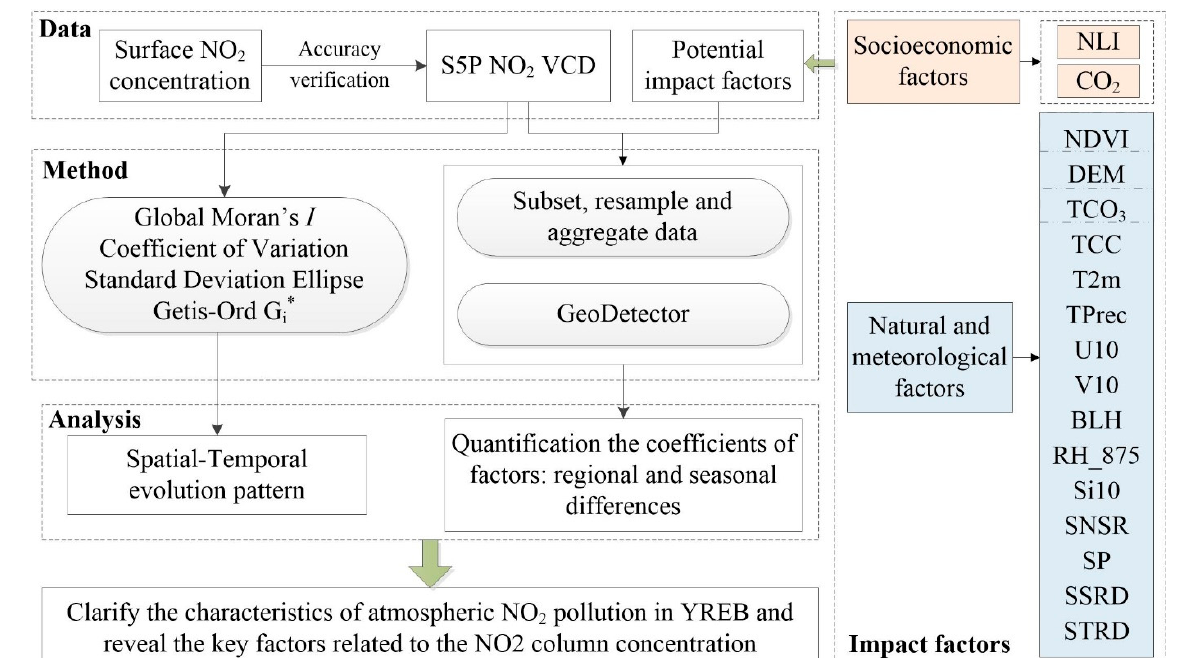
Figure 1. The flowchart of research. (Note: NLI—Nighttime Light; CO 2 —Carbon Dioxide emissions from fuel combustion, cement production and gas flaring; NDVI—Normalized Difference Vegetation Index; DEM—Digital Elevation Model; TCO 3 —Total Column Ozone; TCC–Total Cloud Cover; T2 m—2 m temperature; TPrec—Total Precipitation; U10—10 m u-component of wind; V10—10 m v-component of wind; BLH—Boundary Layer Height; RH_875—875 hPa Relative Humidity; Si10—10 m wind speed; SNSR—surface net solar radiation; SP—surface pressure; SSRD—surface solar radiation downward; STRD—surface thermal radiation downward).